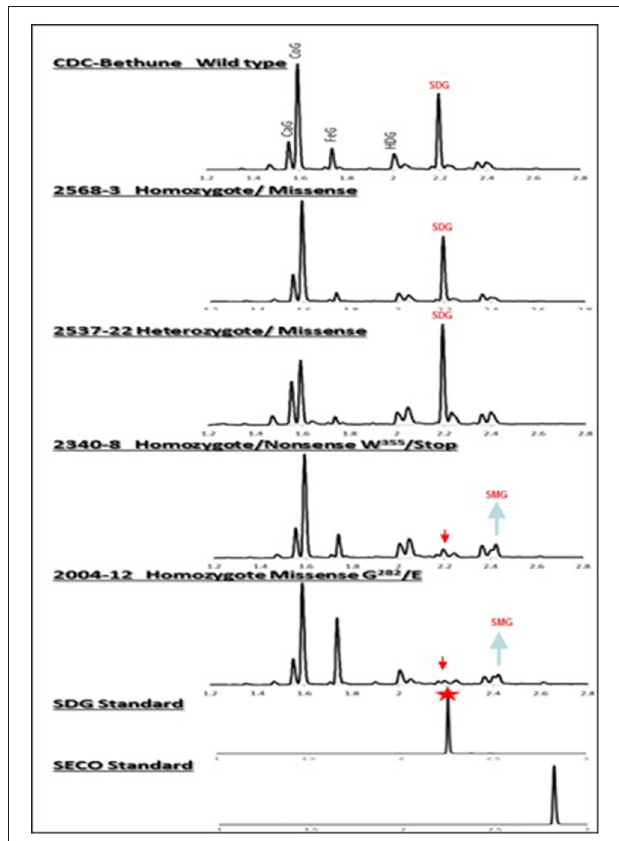
FIGURE 4 | UPLC chromatograms of hydrolyzed lignan complex from M4 seed derived from M3 single seed descent lines and seed from CDC Bethune showing the diversity in SDG profile. The peaks of phenolic acid glucosides and SDG are shown on the top. CaG, caffeic glucoside; CoG, coumaric glucoside; FeG, ferulic glucoside; HDG, herbacetin diglucoside. The red arrows indicate the disappearance of SDG peaks in homozygote nonsense (#2340) and missense (#2004) M4 lines compared to CDC Bethune. Note the equal and higher SDG peaks in the seed from homozygous (#2568) and heterozygous (#2537) lines carrying missense mutations. SDG peak from the SDG standard is indicated by the red